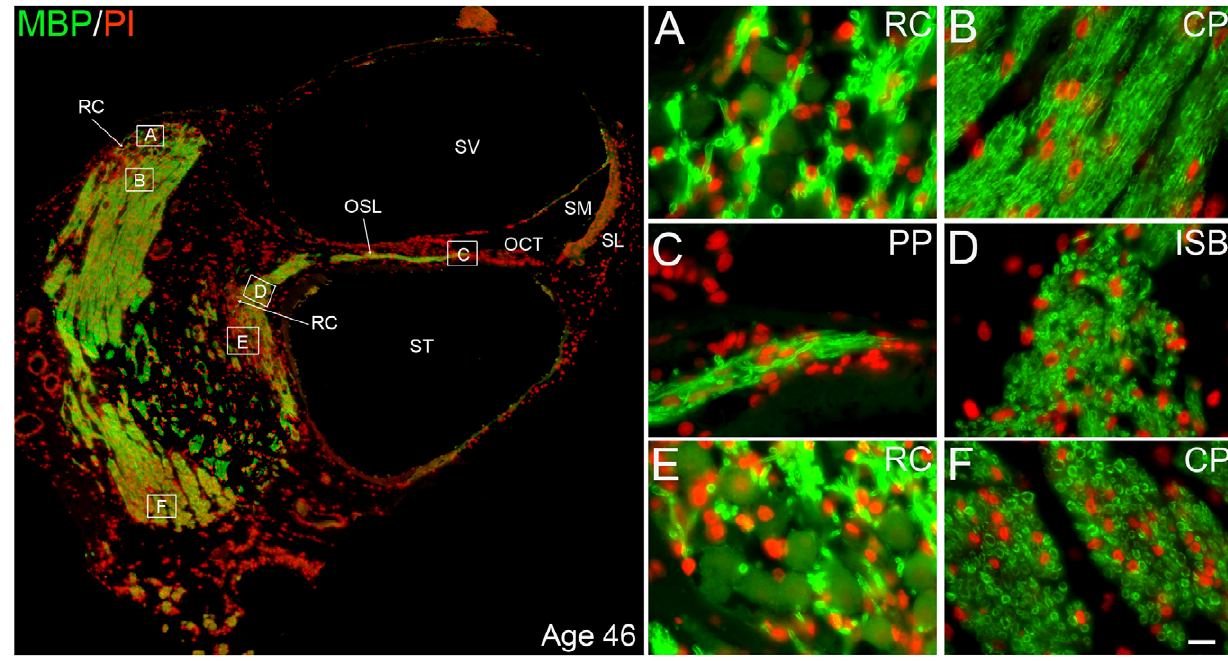
Figure 6. Immunolocalization of MBP in middle-aged human ears. Left panel: Low-power view of apical and middle turns from a 46-year- old donor illustrating auditory nerve fibers in different regions stained positively for MBP (green). Nuclei were counterstained with PI (red). Right panel: Enlarged images corresponding to the boxed areas labeled A–F in the left panel. A: MBP + fibers located within Rosenthal’s canal (RC) of the apical turn. B: MBP + fibers in the central projection (CP) of the auditory nerve within the modiolus close to the apical turn. C: MBP + fibers in the peripheral process (PP) of the auditory nerve within the osseous spiral lamina (OSL). D: MBP + intraganglionic spiral bundle (ISB) fibers in the middle turn. E: MBP + fibers located within Rosenthal’s canal of the middle turn. F: Transverse section of MBP + fibers in the CP within the modiolus close to the middle turn. Additional abbreviations: OCT, organ of Corti; SL, spiral ligament; SM, scala media; ST, scala tympani; SV, scala vestibuli. Scale bar, 7 m m in F applies to A–F .